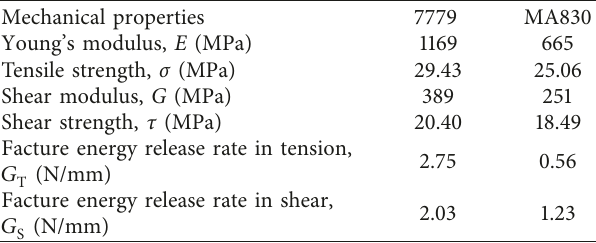
Table 1: Mechanical properties of the two adhesives.